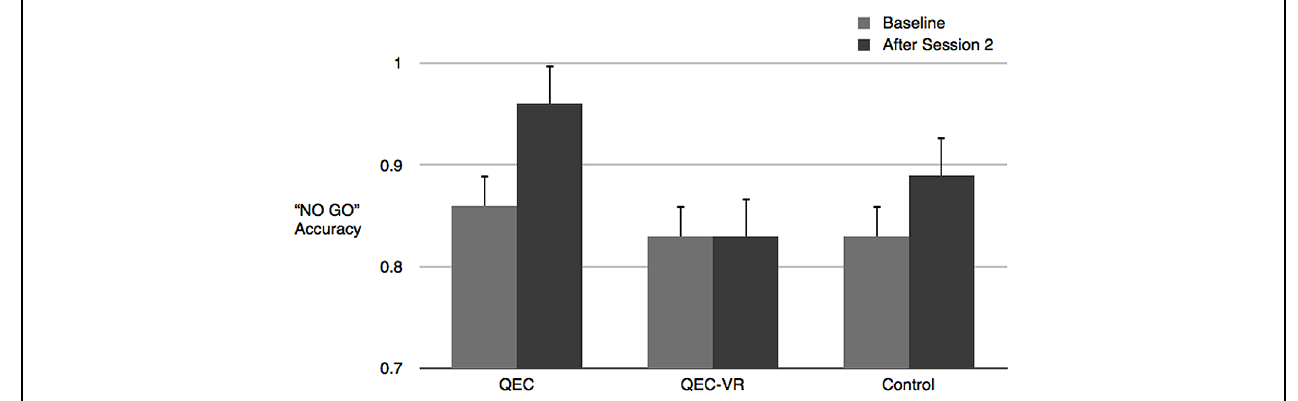
FIGURE 3 | Pre- and post-scores on mind-wandering. Mean ± SEM.